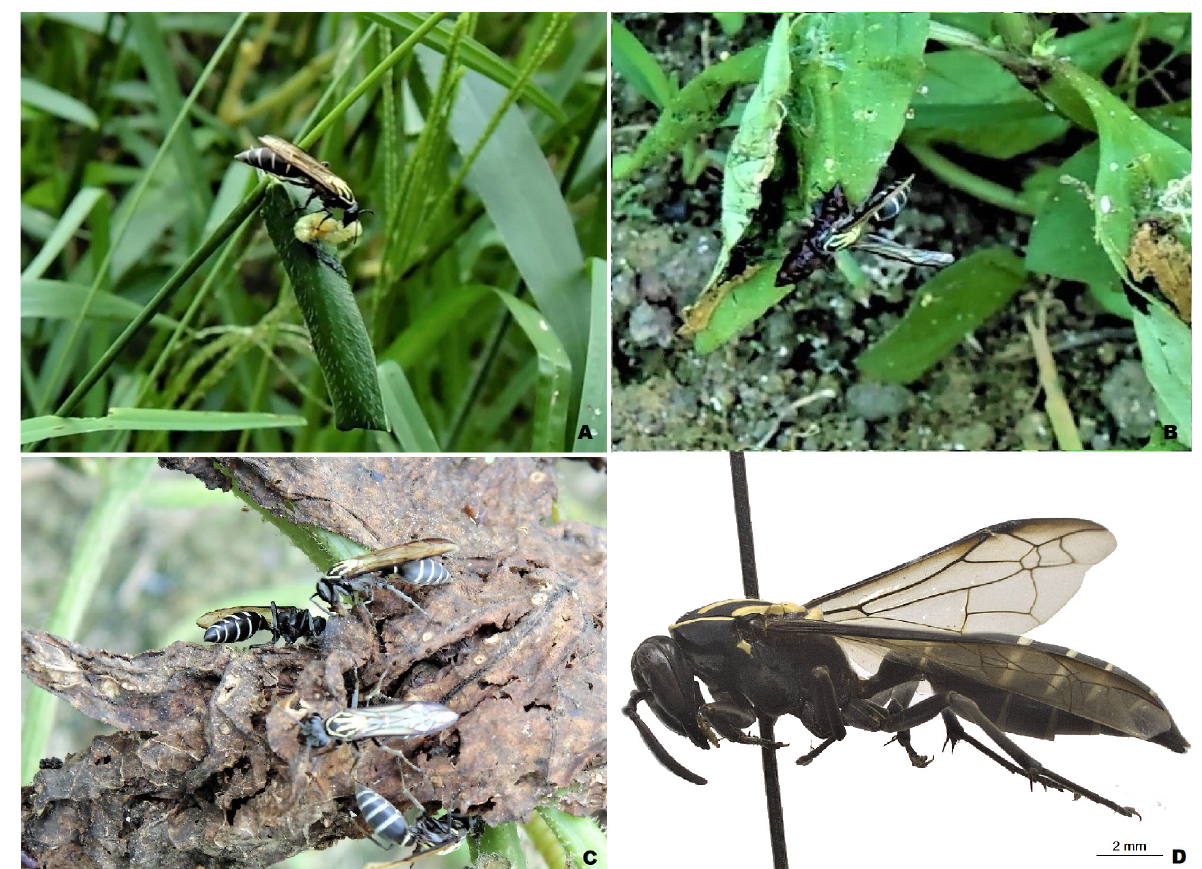
Fig 2 . Polybia liliacea preying on Diaphania hyalinata : (A) fifth instar larvae; (B) pupae; (C) Polybia liliacea in pupation site; (D) P. liliacea in lateral